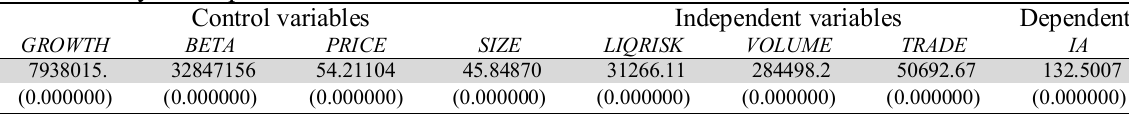
The summary of Jarque–Bera